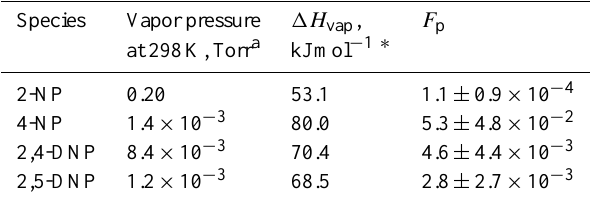
Table 2. Vapor pressure, enthalpy of evaporation ( (cid:49)H vap ) , and cal- culated concentration fractions in the particle phase ( F p ) for several nitrated